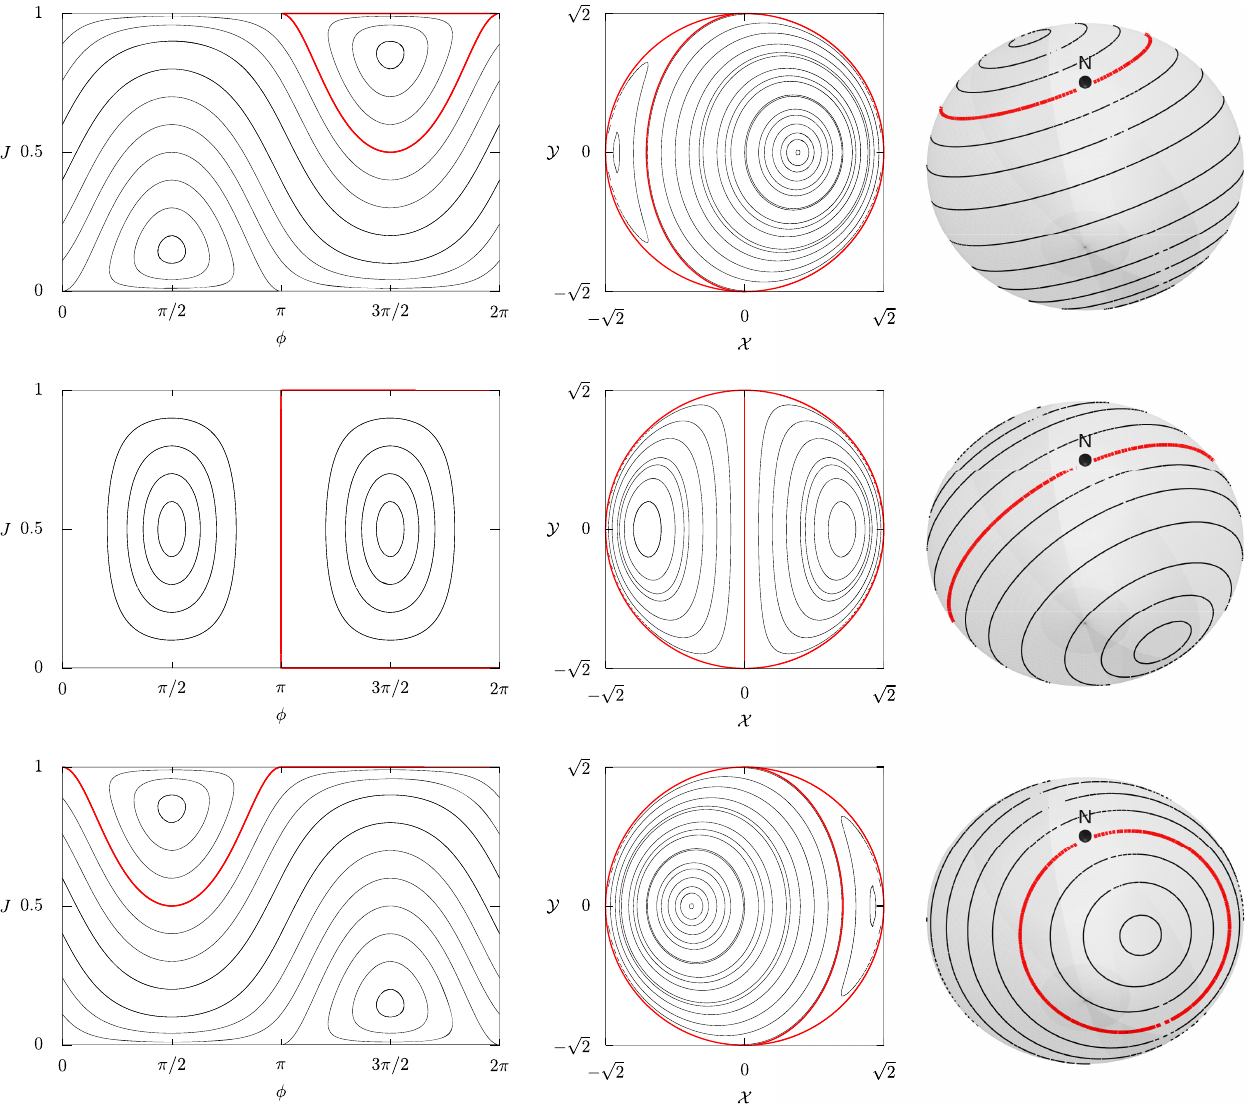
ffiffiffiffiffi ffiffiffiffiffi p p 2 J 2 J sin ϕ ; Y ¼ cos ϕ Þ in the